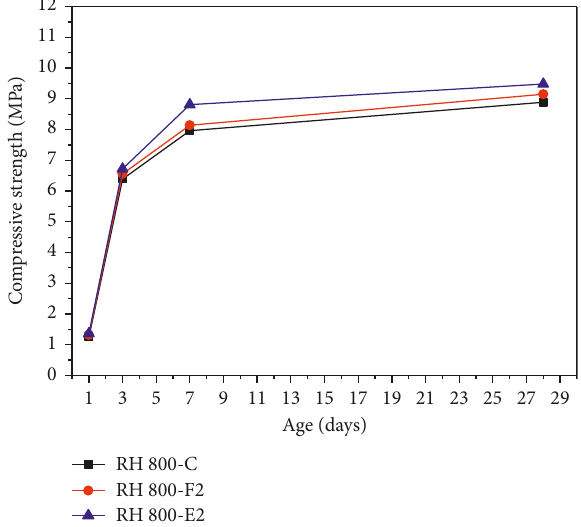
Figure 8: Compressive strengths of the foam concrete versus time.